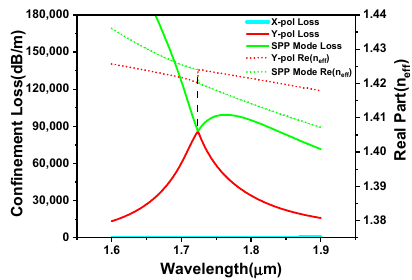
Figure 2. The confinement loss and dispersion relations of the core mode and SPP mode of the MPF–SPR sensor. The RI of the analyte is n a = 1.38.